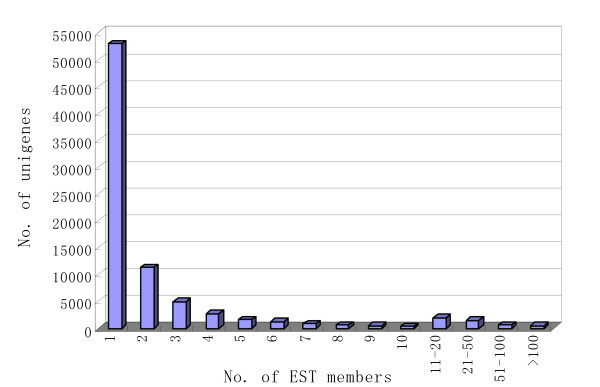
Distribution of number of EST members in each cucumber unigene.